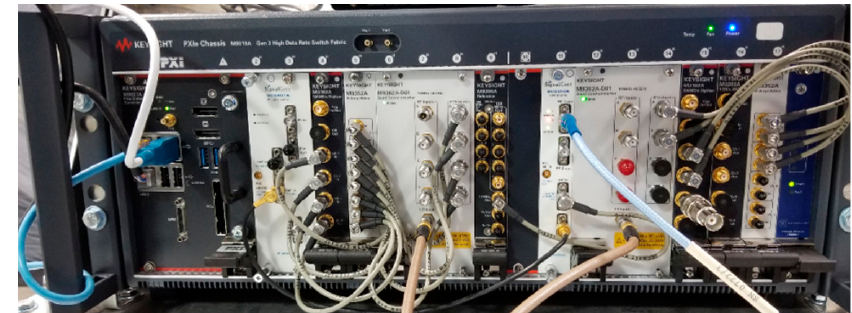
Figure 3. PXIe 8-channel microwave digital receiver.